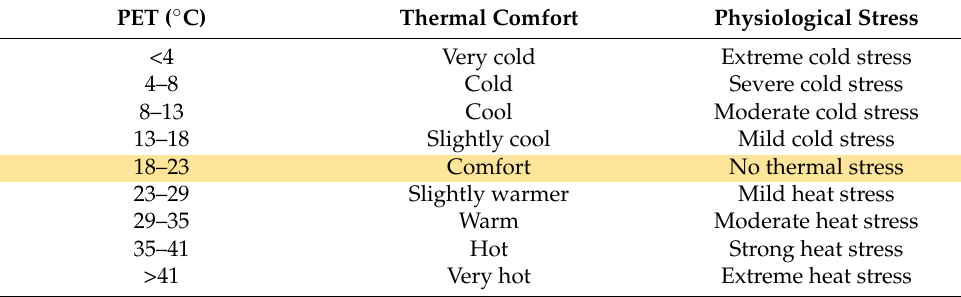
Table 7. Outdoor thermal comfort classification table.